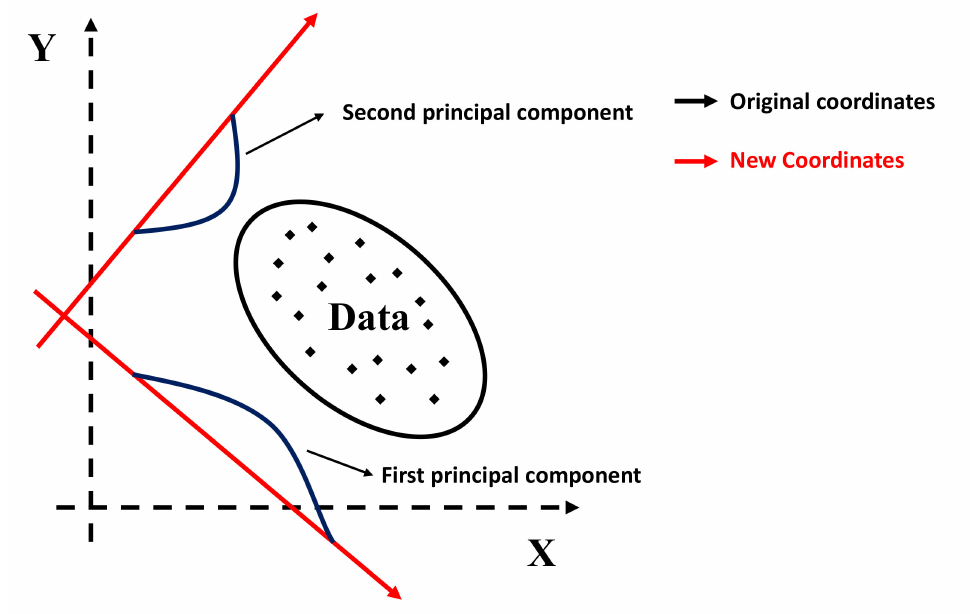
Figure 1. Schematic of the